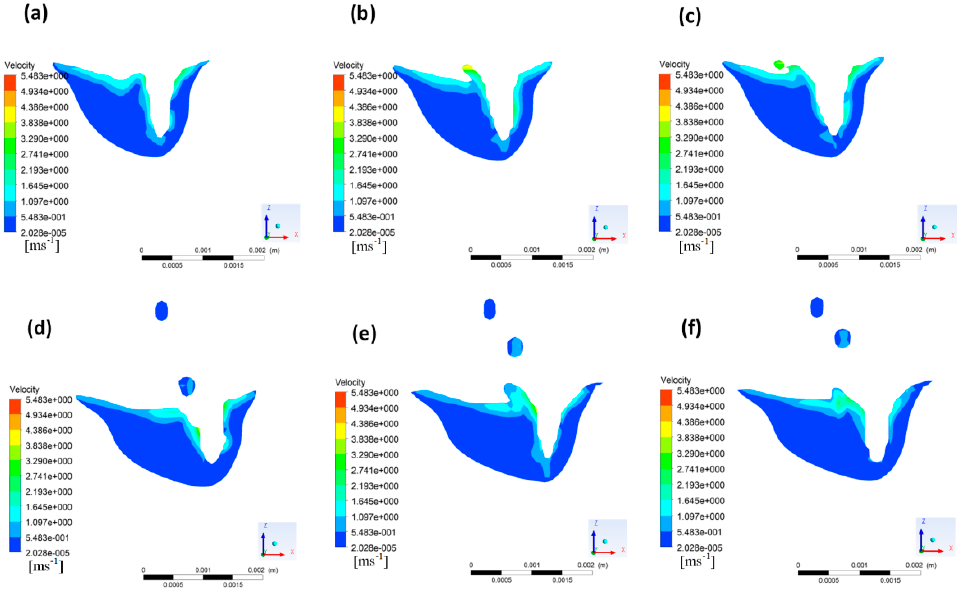
Figure 11. Velocity contour of the molten pool when the welding speed was 9 m/min: ( a ) t = 7.6 ms, ( b ) t = 7.9 ms, ( c ) t = 8 ms, ( d ) t = 12.5 ms, ( e ) t = 13.2 ms, ( f ) t = 13.4 ms.